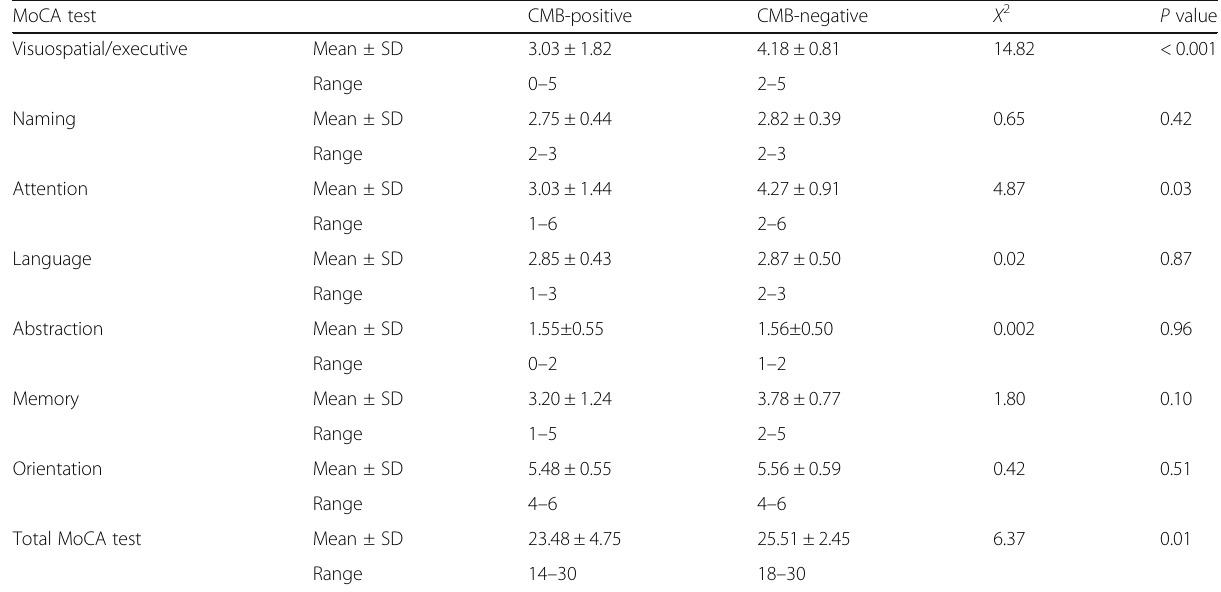
Table 4 Comparison between groups according to MoCA test MoCA test